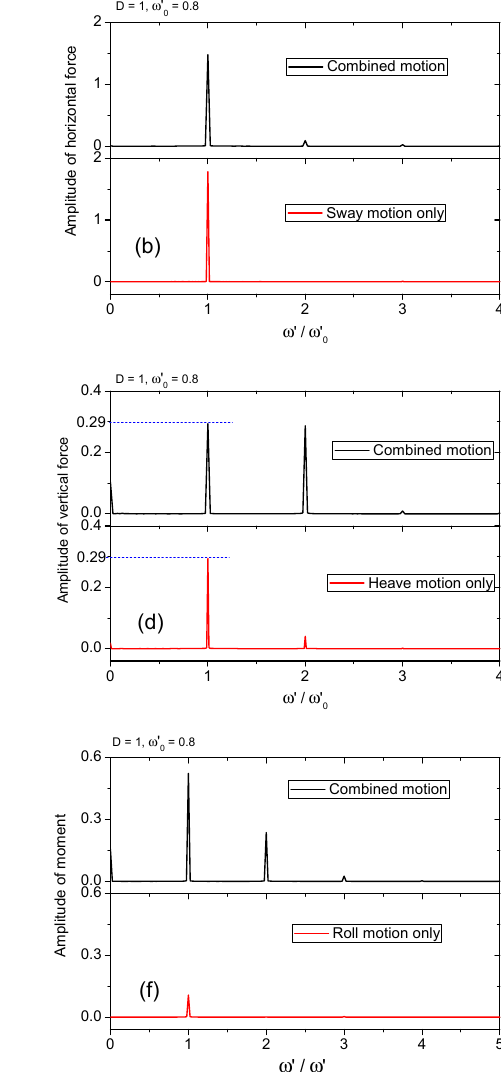
Figure 16. Comparisons of combined motion with those of single-mode motion when ω (cid:48) 0 = 0.8: ( a , b ) horizontal force comparison with sway motion; ( c , d ) vertical force comparison with heave motion; ( e , f ) moment comparison with roll motion.